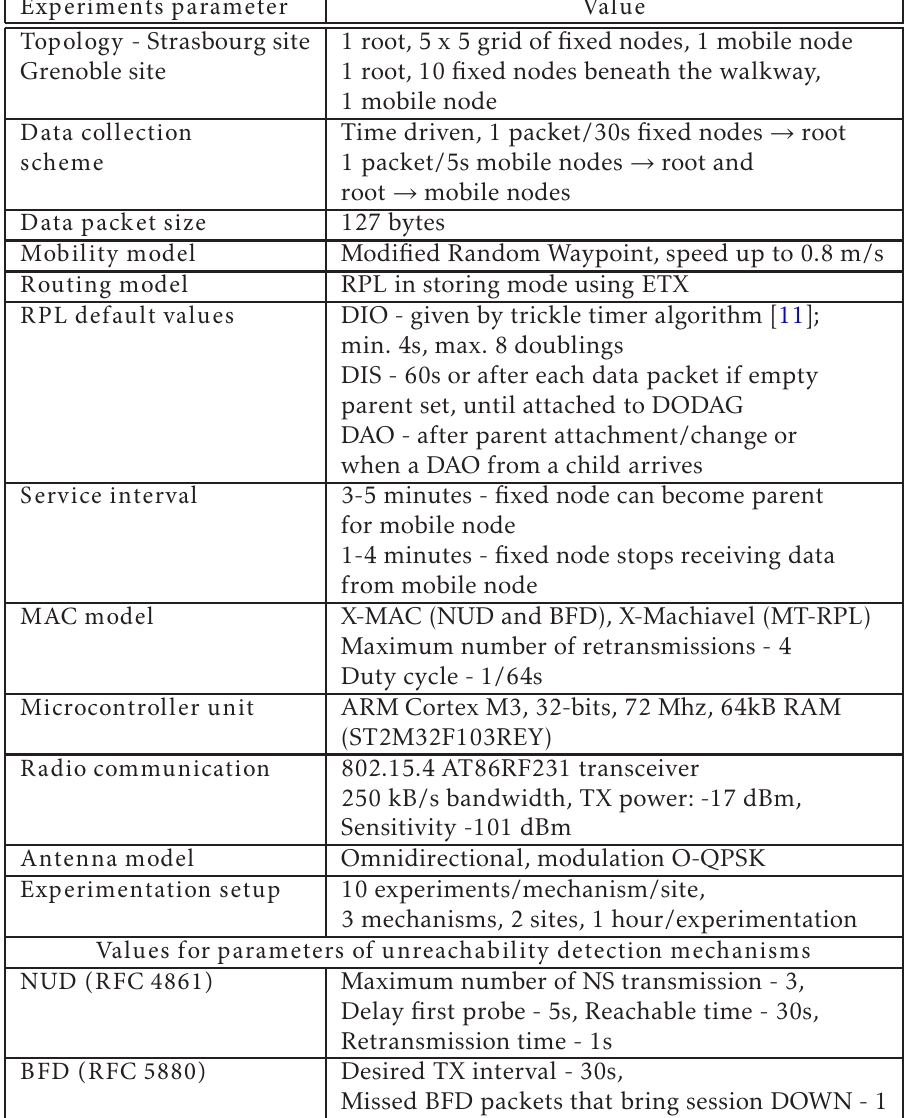
Table 1. Experiments